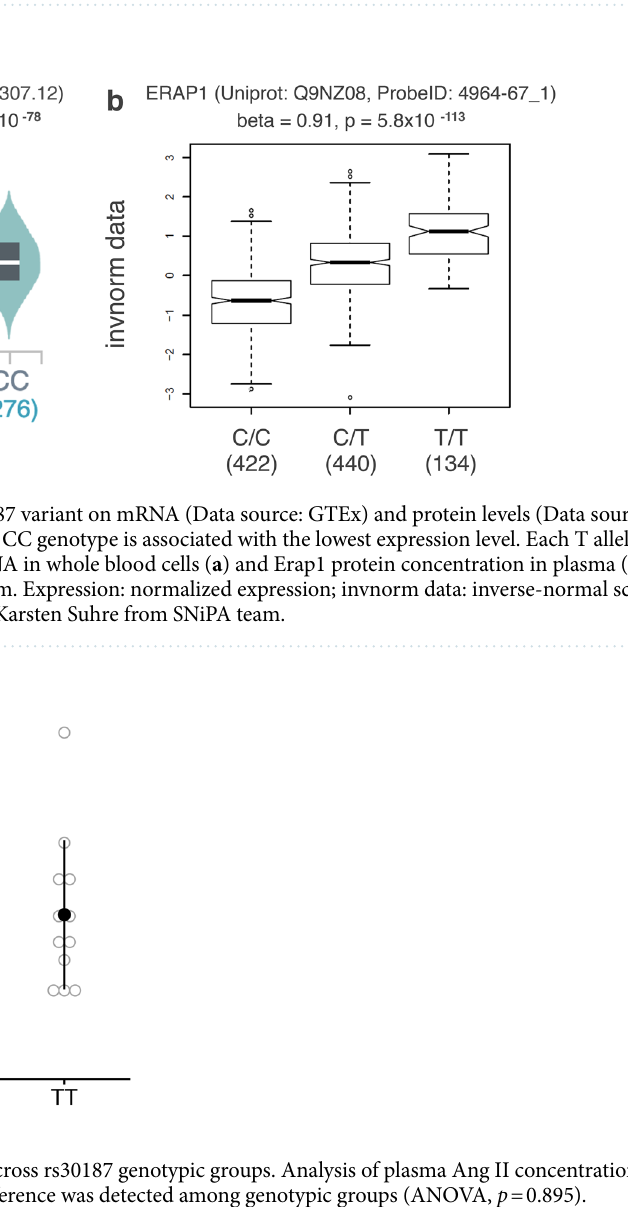
Table 4. Genetic effect of rs30187 on eclampsia risk under recessive genetic model. a Chisquared test of association for genotype distribution between Control and Eclampsia ( p = 0.022). b Odds ratio (OR) and confidence interval (CI) estimated by logistic regression model adjusted for maternal age and parity.